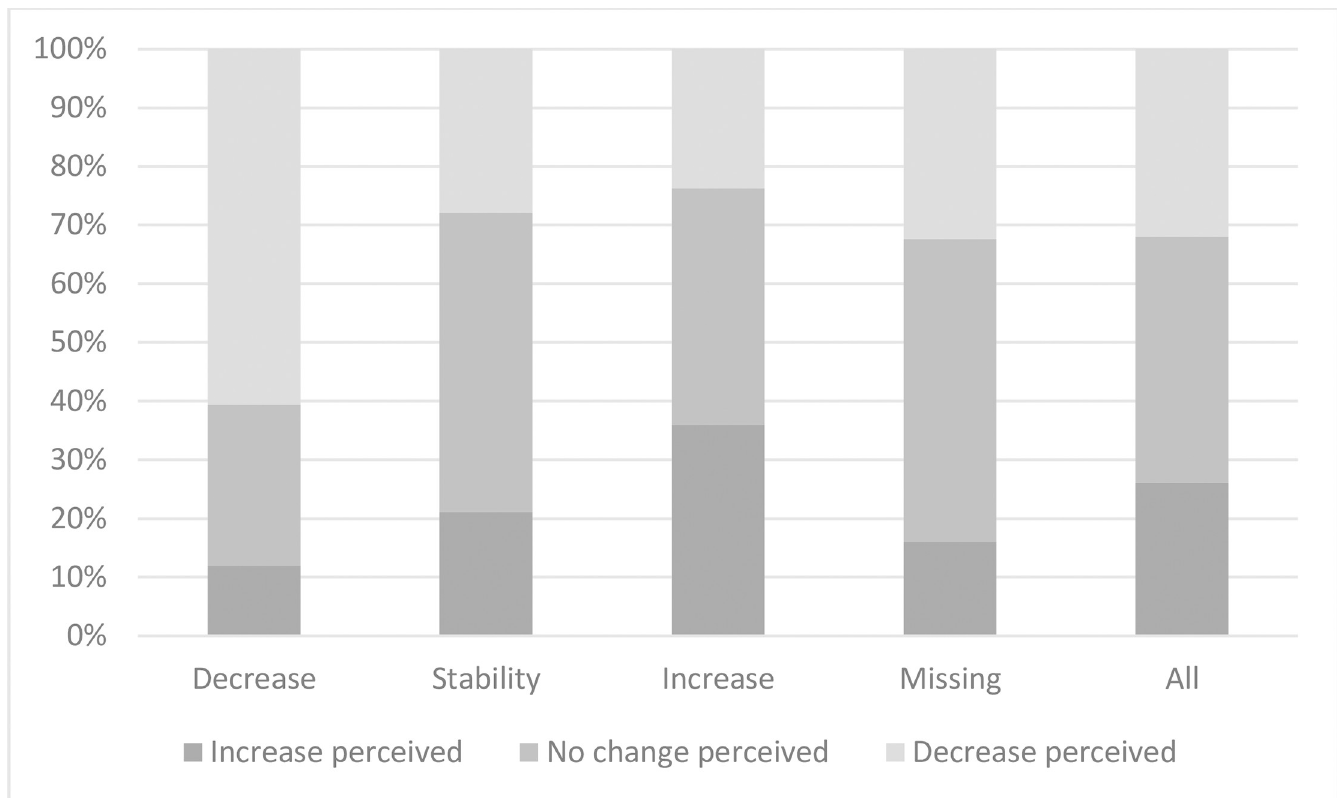
Fig 2. Perceived variation in household income according to actual variation (in %) (N = 1,636).